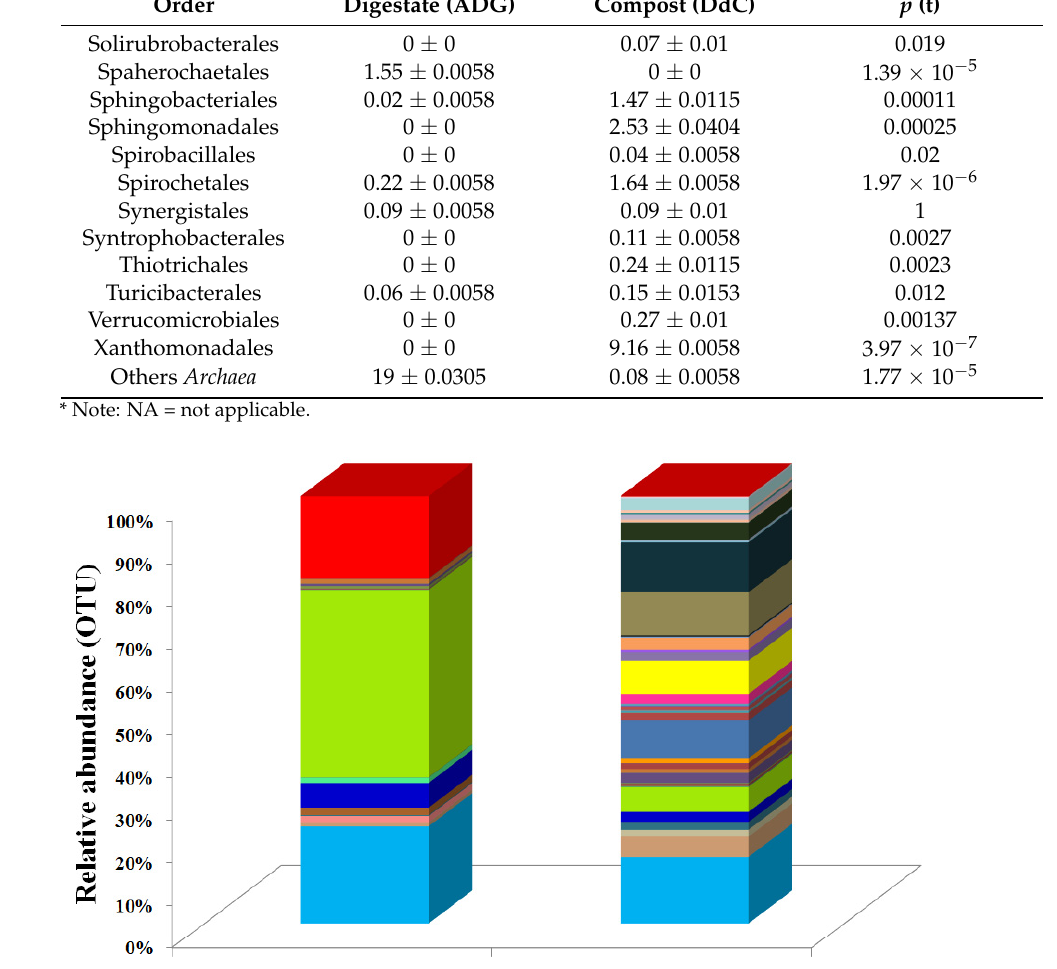
Dehalococcoidales, Fusobacteriales, Gaiellales, Gemmatales, Legionellales, Neiseriales, Nitrospirales, and Puniceicoccales orders, it was not possible to perform the Stundent’s t -test since their abundances were extremely low or zero (Table 2).